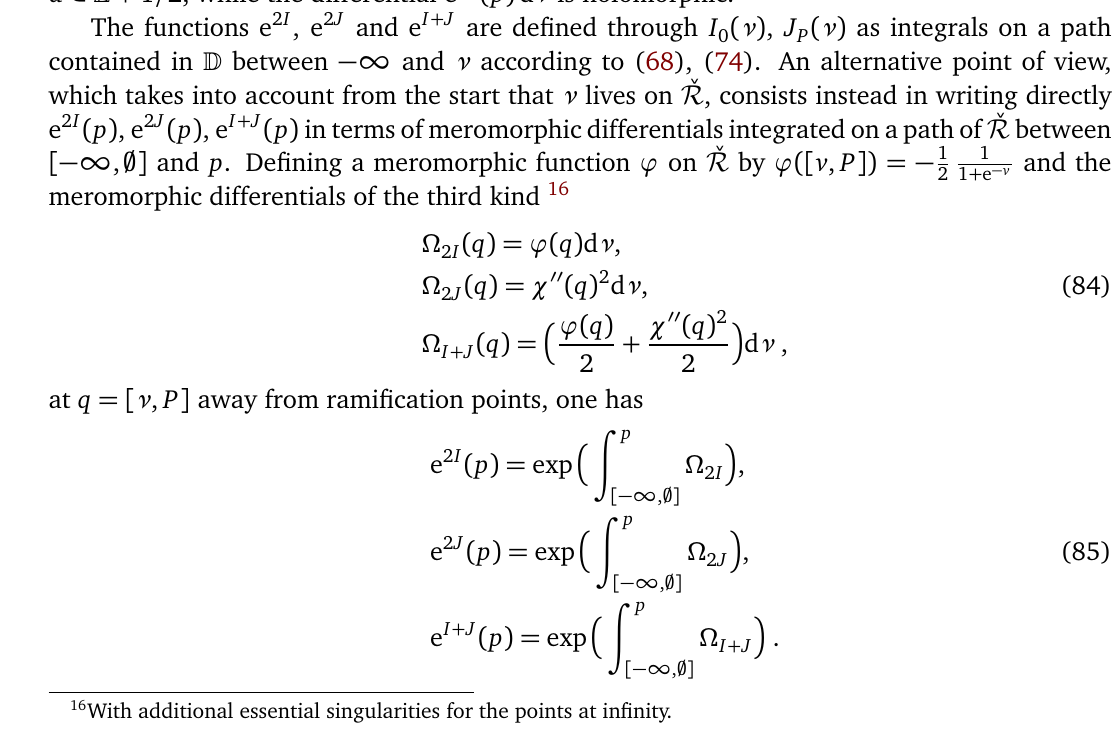
Figure 21: Decomposition of a loop (cid:96) β · Q . Paths on various sheets (cid:67) n